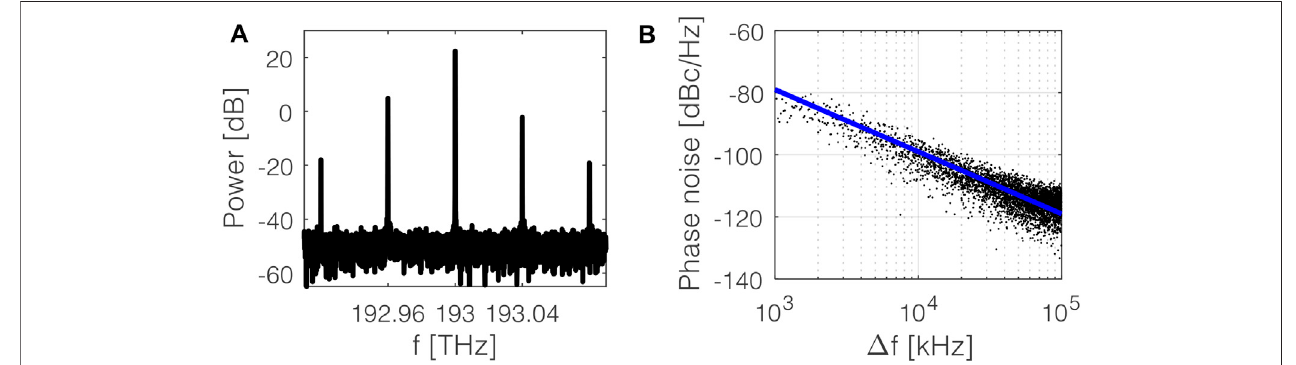
FIGURE 8 | (A) OEO output spectrum; (B) phase noise vs. Δ f = f – f osc